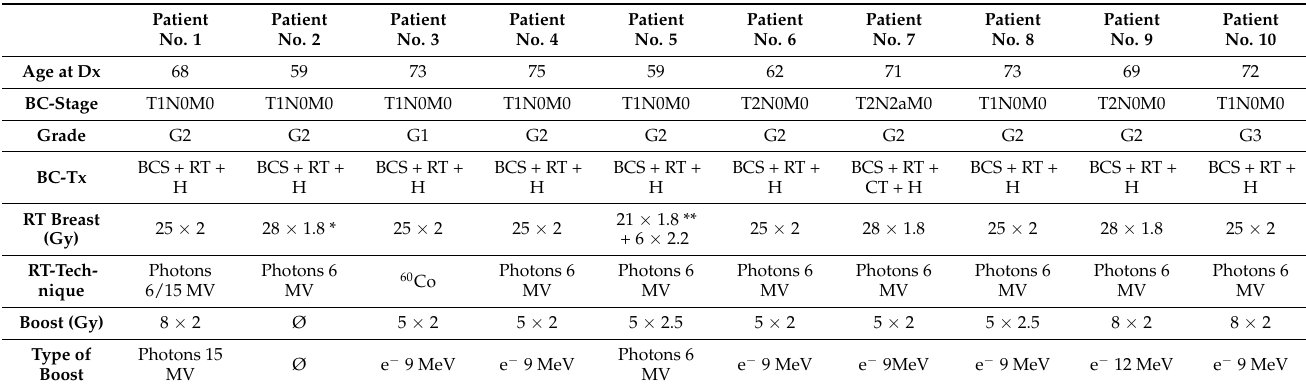
Table 1. Former breast cancer treatment of patients with